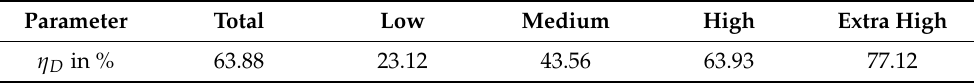
Table 7. Sectioned and total WLTP drivetrain efficiency in% for the Kia